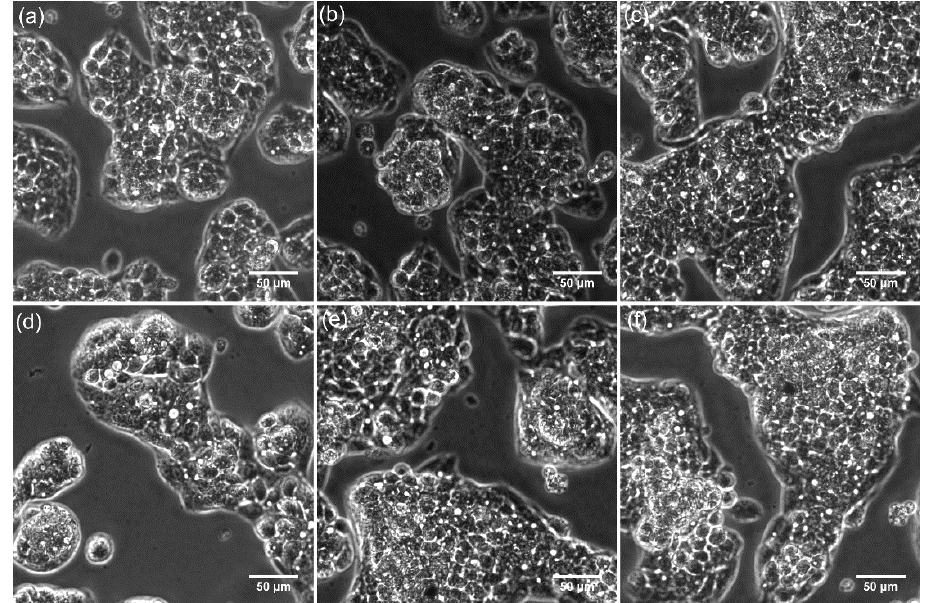
Figure 10. Microscopic images of HepG2 control cells ( a – c ) at different time intervals (24, 48, and 72 h) and HepG2 cells grown on dextran thin films deposited on glass substrate ( d – f ) at different time intervals (24, 48, and 72 h).